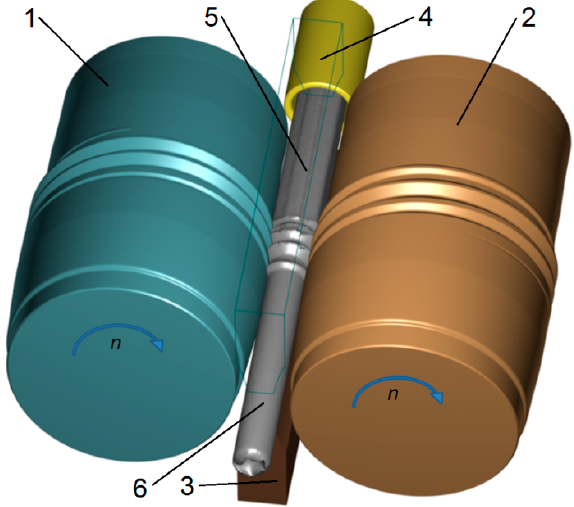
Figure 4. Geometric model of the second stage of the rolling process—skew rolling in the helical roll pass: 1,2—rolls, 3—guide, 4—guiding sleeve, 5—preform rolled in the first stage, and 6—final rod product.